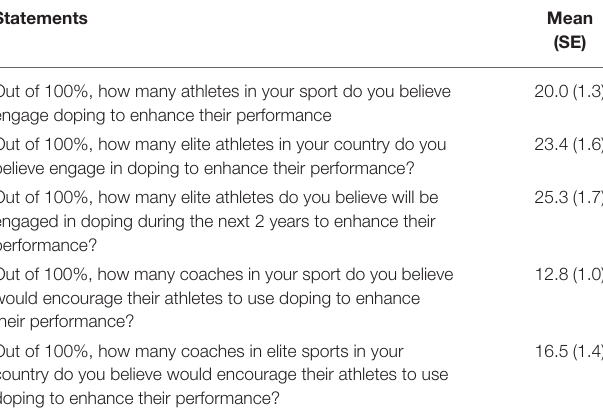
TABLE 2 | Descriptive norms: coaches’ beliefs regarding others’ use of